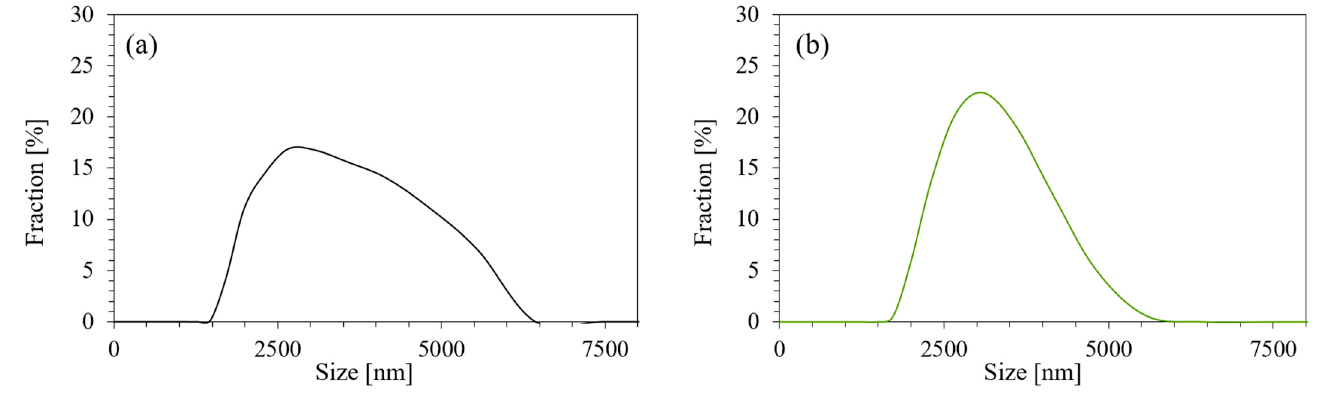
Figure 3. Distribution of particle size of ( a ) unmodified plum filler; ( b ) silanized plum filler.